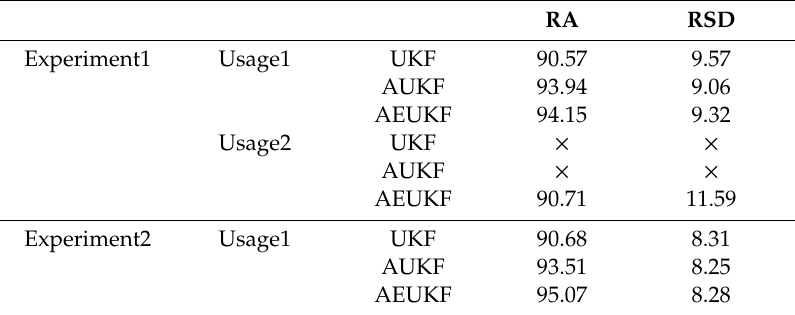
Figure 13. Fault profile in 𝛽 (cid:3087)(cid:3045) .